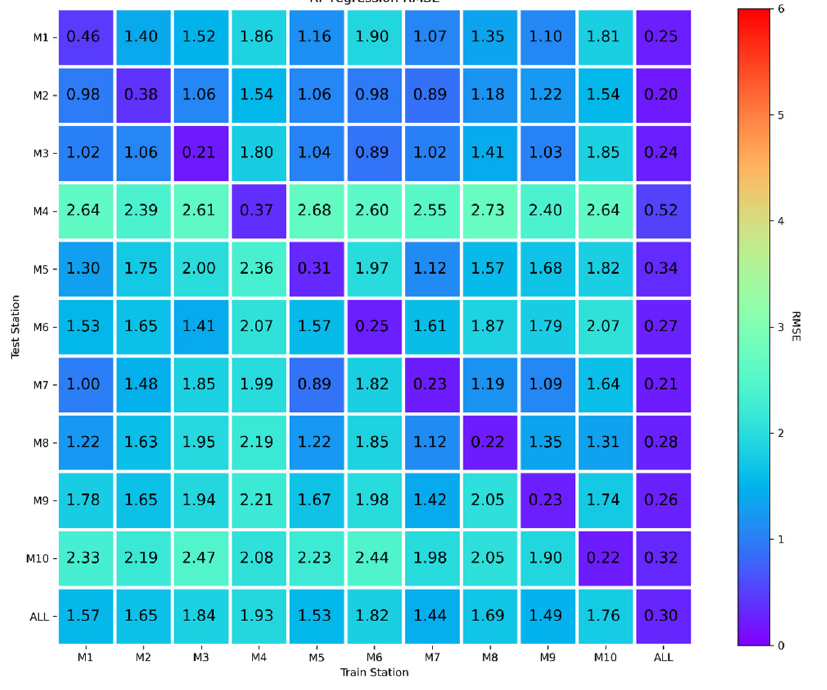
Figure 5. The RMSEs of results predicted by RF regression method with different training and test data.